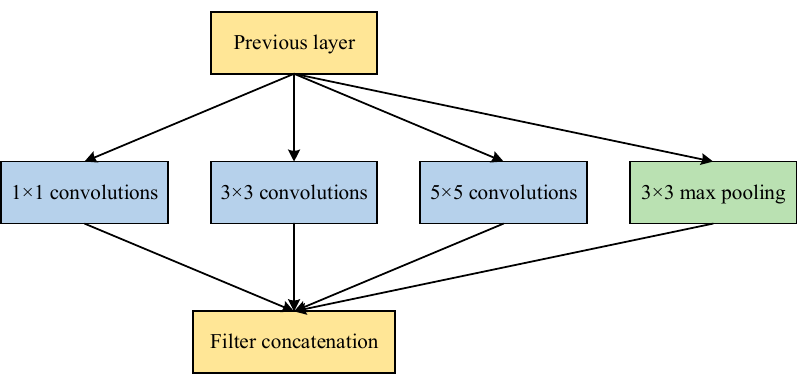
Figure 8. Basic structure of Inception model.